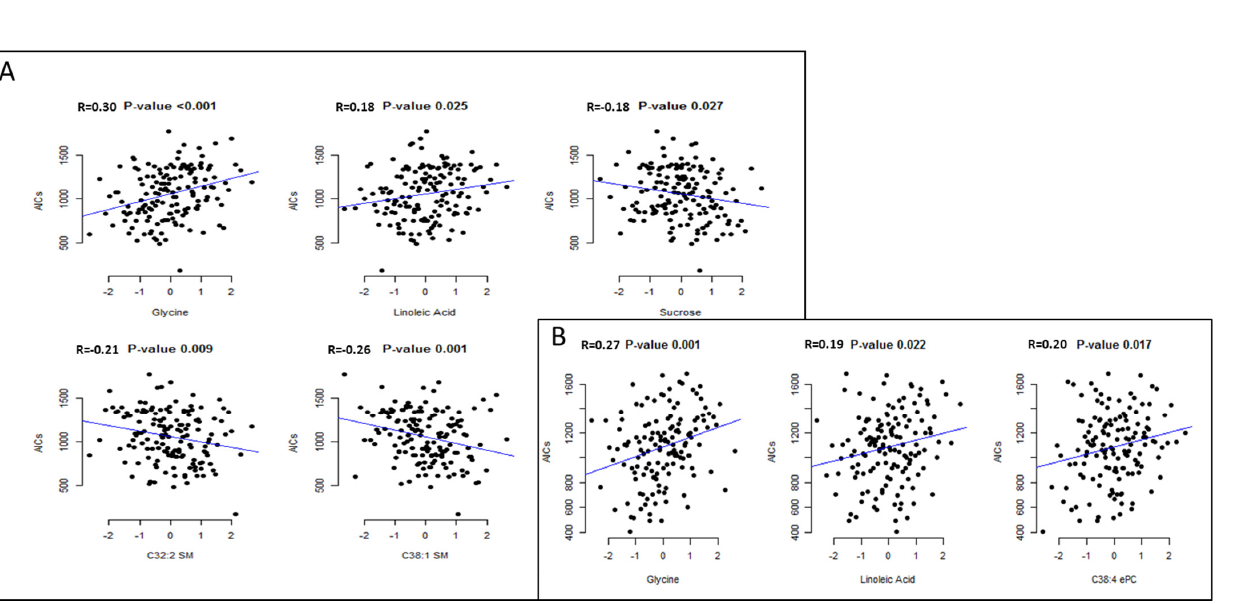
Figure 2. Scatter plots of the data between the metabolite levels and the VAS scores at the first ( A ) and the second ( B ) appetite assessment. Pearson correlation coefficients for the association of each metabolite selected in the elastic net regression with the VAS scores.